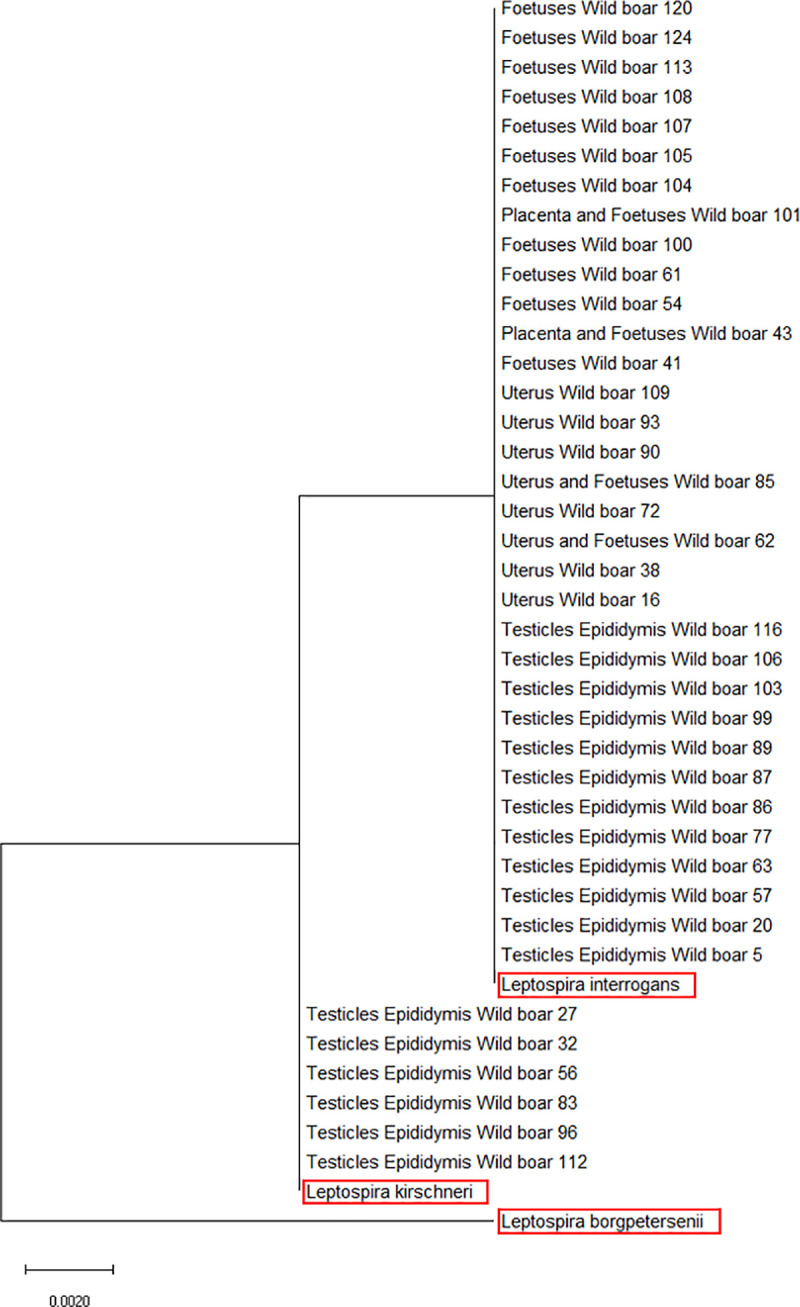
Molecular phylogenetic analysis for PCR-positive tissue samples based on the rrs2 gene of Leptospira interrogans, Leptospira borgpetersenii, and Leptospira kirschneri (in the red box with the GenBank Accession Number) by the Maximum Likelihood method based on the Tamura-Nei model.The branch lengths of the tree measure the number of substitutions per site. The analysis involved 31 nucleotide sequences. There was a total of 452 positions in the final dataset.